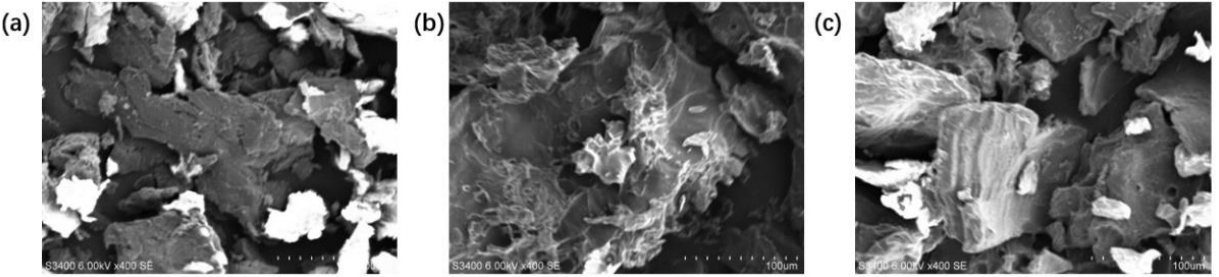
Figure 7. SEM micrographs of CS ( a ), CSC ( b ), and CSS ( c ).